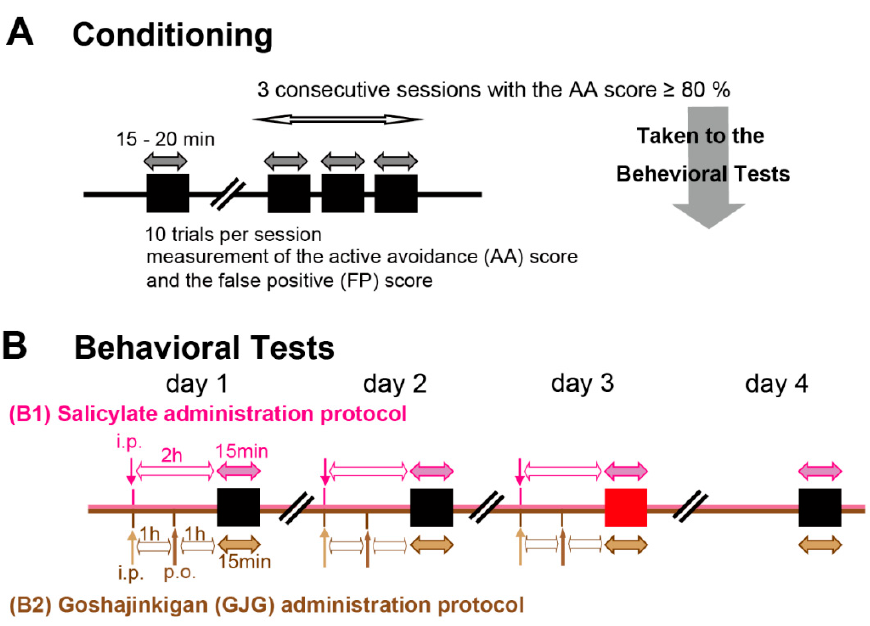
Figure 1. Schematic representation of the behavioral test protocol. ( A ) Conditioning protocol. Ani- mals were conditioned to move to the opposite chamber in response to a sound presentation. Each session of 10 trials lasted 15–20 min. When conditioned (criterion: three consecutive sessions with an active avoidance (AA) score ≥ 80%), animals underwent the behavioral tests. ( B ) Behavioral tests. In the salicylate administration protocol (B1), salicylate was intraperitoneally injected 2 h before the behavioral measurement (i.p., pink arrow). In this behavioral test, the correct movements to sound (AA score) and the movements during intertrial periods without sound (false positive (FP) score) were measured in a 15 min session. The drug was intraperitoneally injected daily for three days, and the behavioral test was performed daily for four days. In the goshajinkigan (GJG) administra- tion protocol (B2), salicylate was intraperitoneally injected 2 h before the behavioral measurement (i.p., light brown arrow). Distilled water or GJG was orally administered (p.o., dark brown arrow) 1 h before the behavioral measurement. For the control group, animals received daily i.p. saline injections and following oral administration of DW. The i.p. and p.o. administrations were performed daily for three days, and the behavioral test was performed daily for four